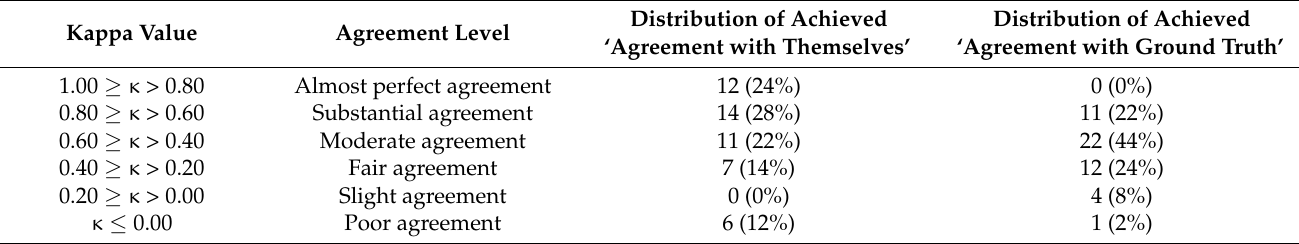
Table 5. Summary of Kappa values by agreement